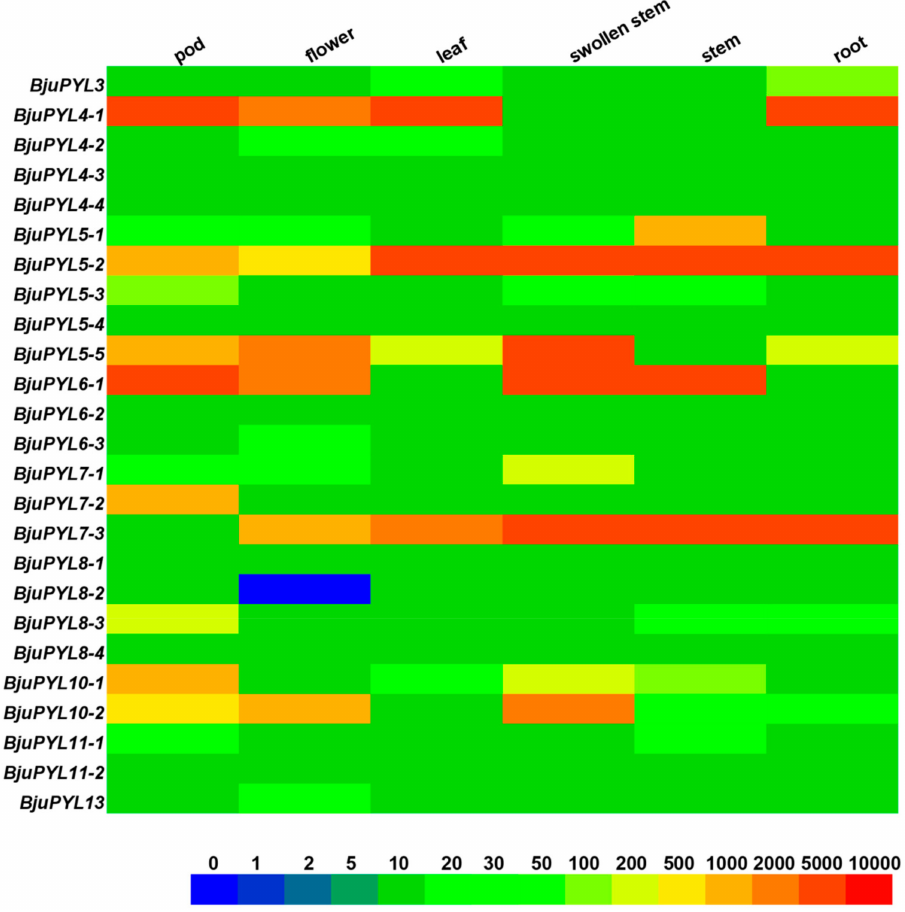
Figure 5. Expression levels of BjuPYLs in di ff erent tissues. Tissue-specific expression pattern of BjuPYLs was analyzed by qPCR. BjuActin3 was used as internal control. The boxes display the gene expression levels, and di ff erent colors represent di ff erent expression